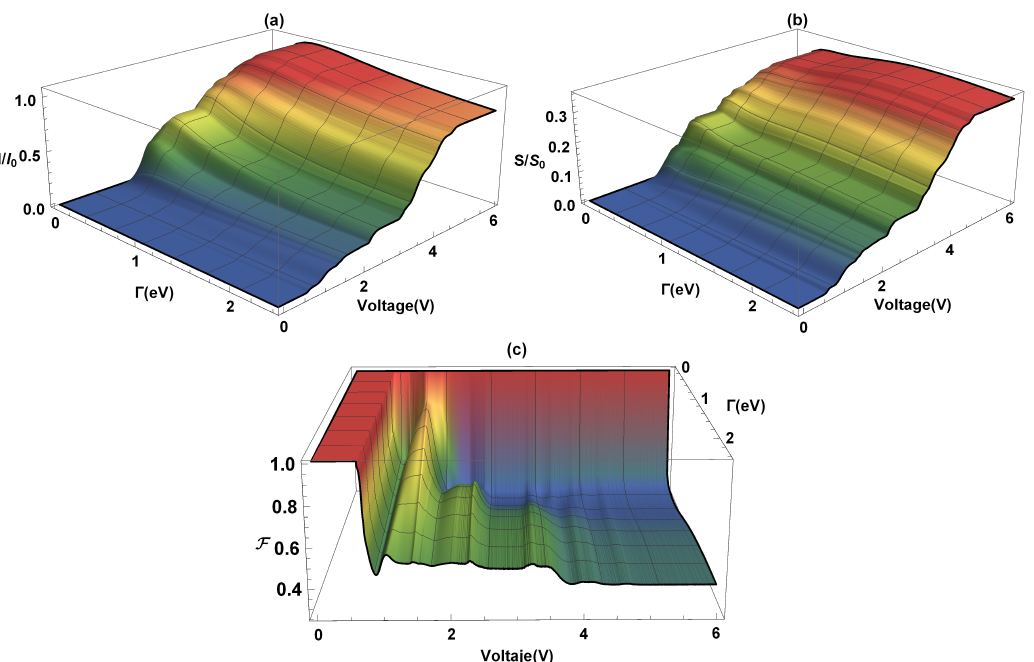
Figure 4. ( a ) Current, ( b ) current fluctuations, and ( c ) Fano factor as a function of the bias voltage ( V ) and the coupling lead-molecules ( Γ